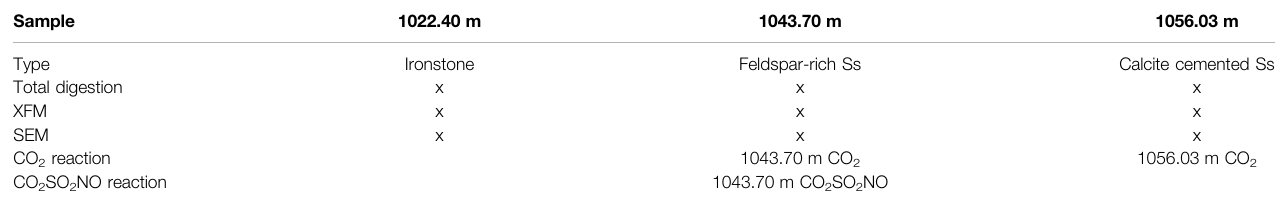
TABLE 1 | Summary of the samples and experiments. X = characterization was performed. Reacted samples include the reaction gas in the sample name as shown here.